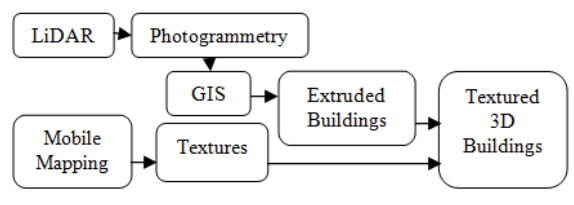
Figure 2. 3D model production